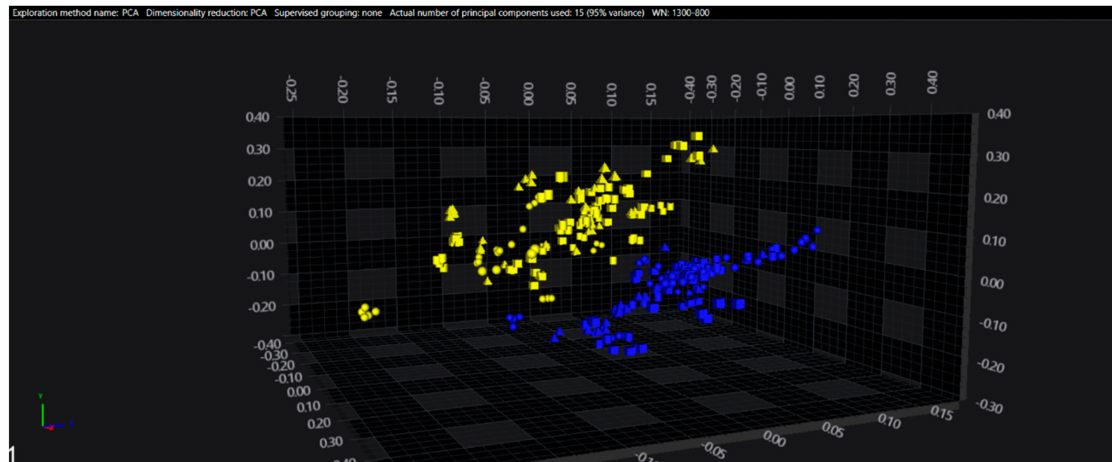
Figure 4. PCA of the O:8 serogroup (blue = Typhi, yellow = other serovars).